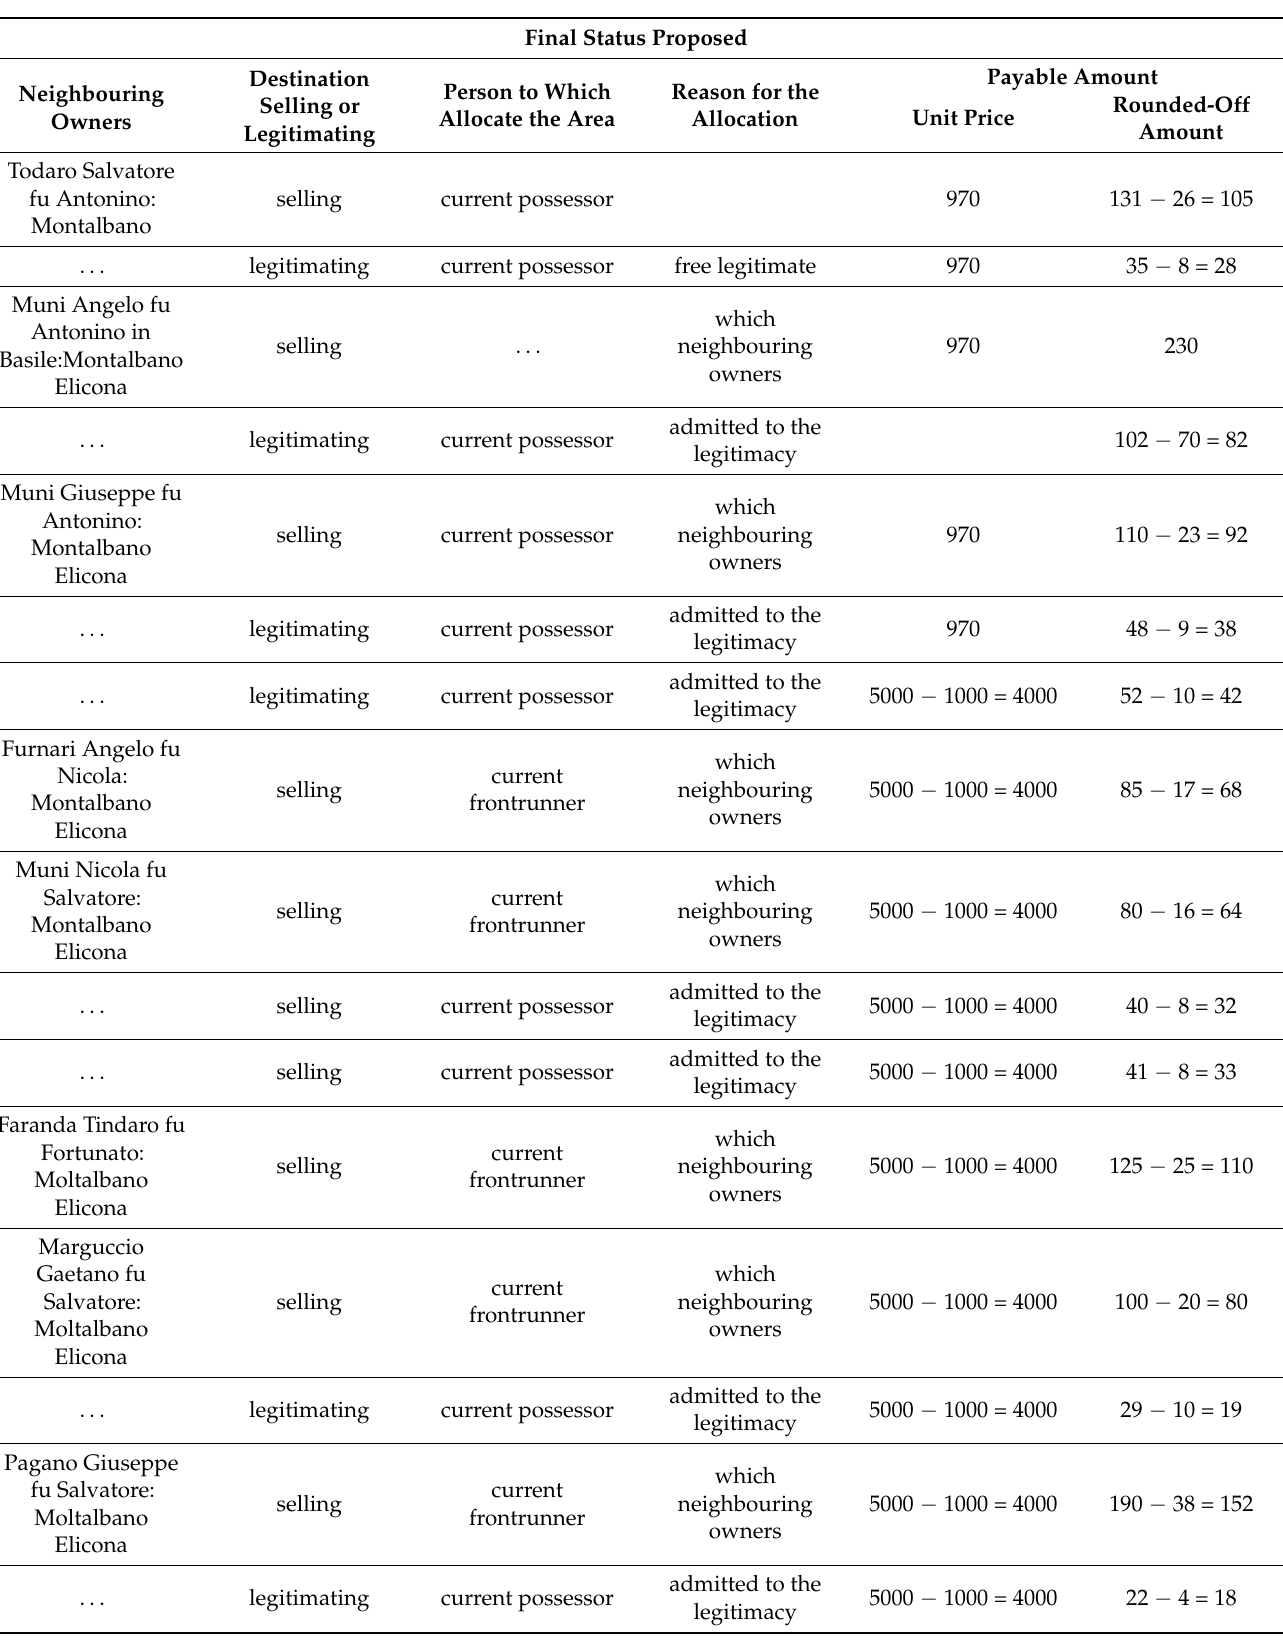
Table A2. Table of the body of register: final status proposed (excerpt). Final Status Proposed Payable Amount Rounded-Off Unit Price Allocation